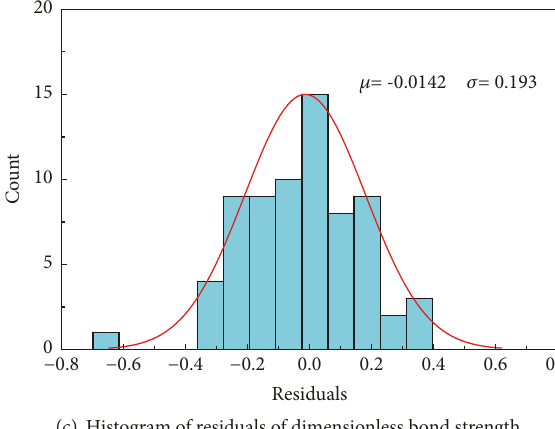
Figure 10: Dimensionless bond strength versus maximum crack width of beam-end specimens: (a) dimensionless bond strength versus maximum crack width; (b) residuals versus maximum crack width; (c) histogram of residuals of dimensionless bond